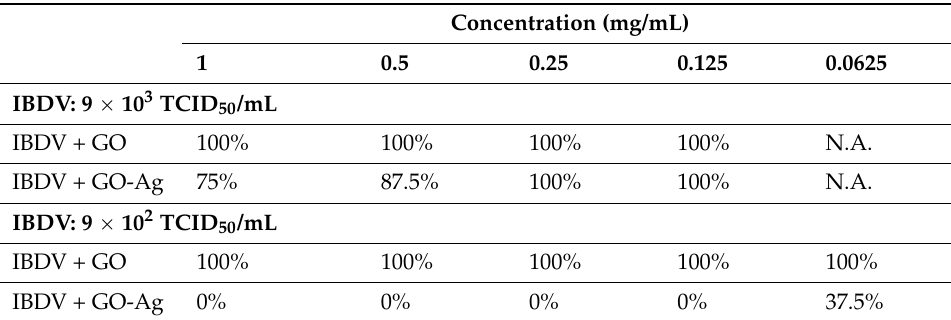
Table 2. Infectivity of viruses inoculated with graphene oxide with